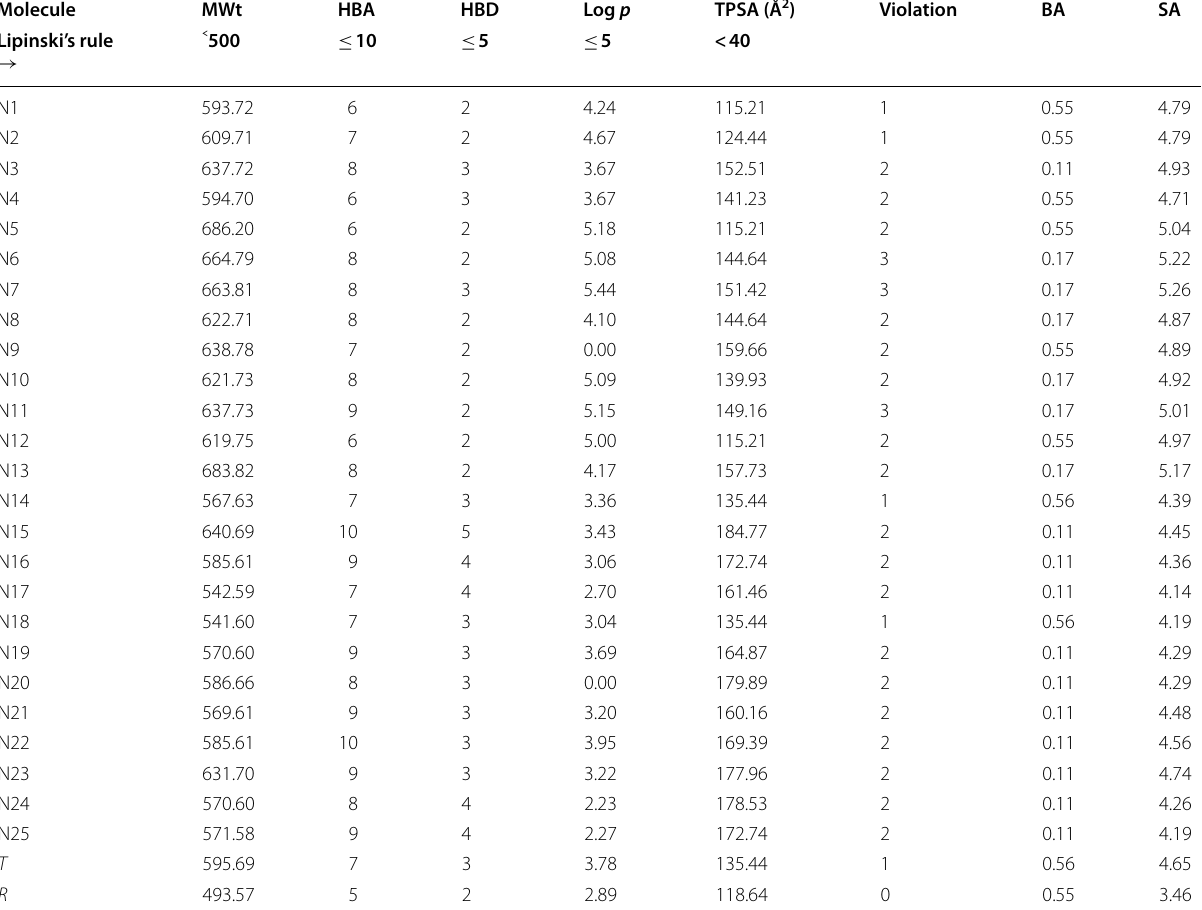
Table 5 Computed drug-likeness based on Lipinski’s rule, bioavailability (BA), and synthetic accessibility (SA) Molecule Lipinski’s